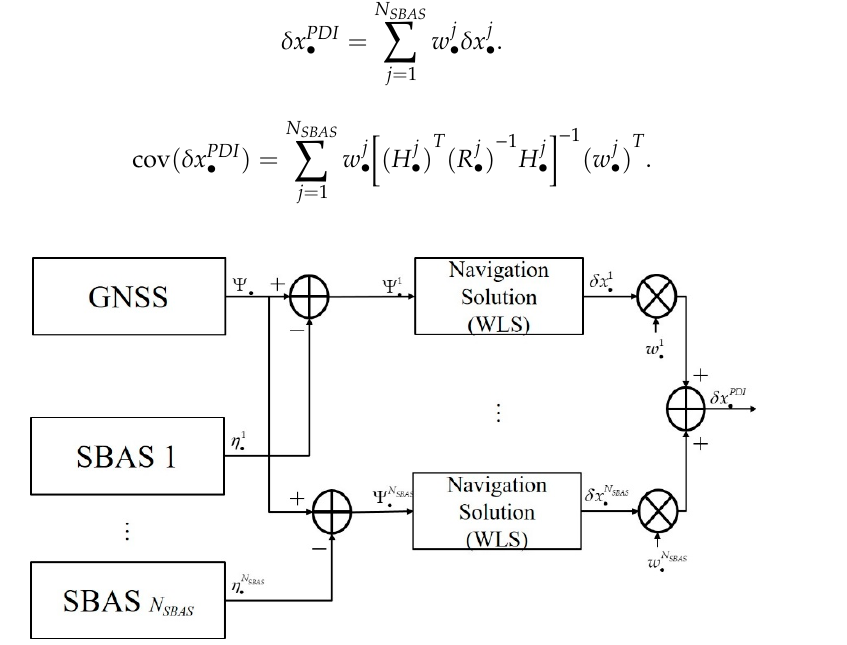
Figure 4. Position domain integration (PDI) for single GNSS augmented with multi-SBAS. Using Equation (25) as an optimum weighting [18], Equations (23) and (24) become Equations (26) and (27),